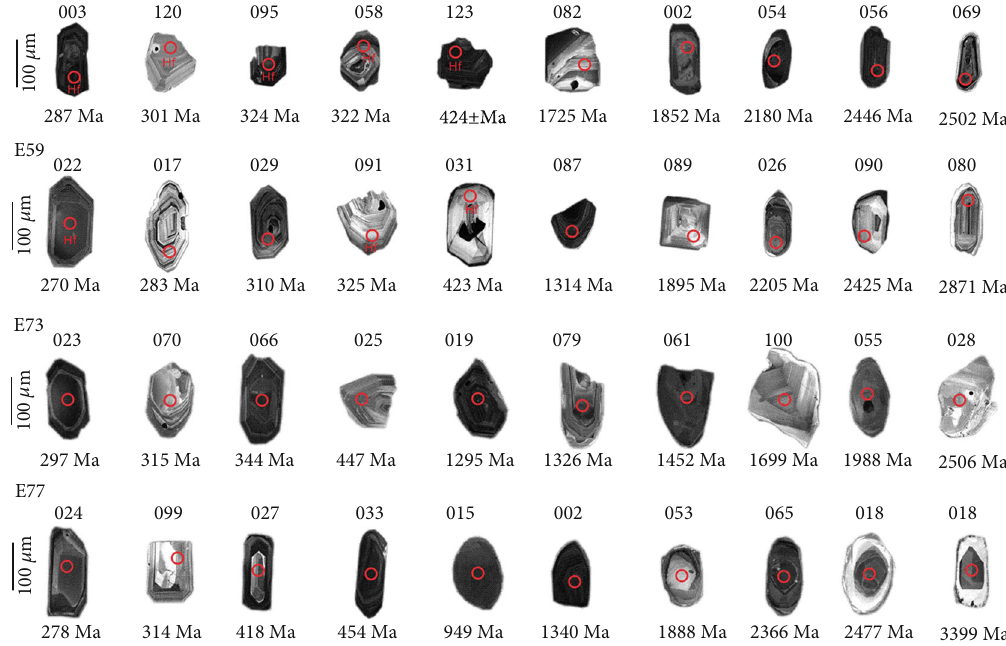
Figure 2: Cathodoluminescence image of detrital zircon samples from the Shanxi Formation in the Etuokeqi